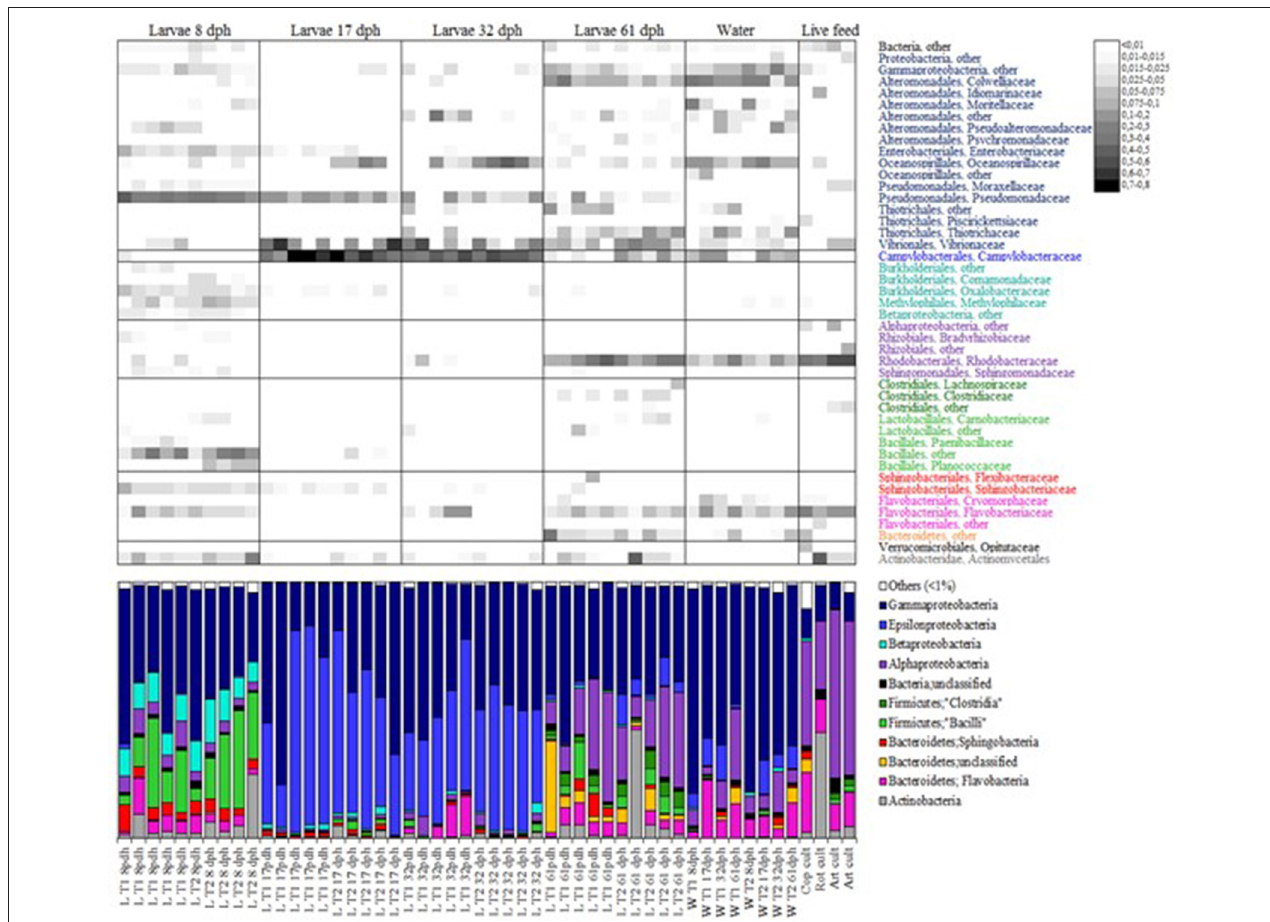
FIGURE 5 | Relative abundance of bacterial phyla and families in individual cod larvae, water and live food samples determined by 16S rDNA amplicon sequencing. At the phylum level, the microbiota is presented as percent bar graphs (bottom), and at the family level as a heat map (top, scale upper right) with the abundance of each family represented by a colored block as specified in the figure. Bars labeled D8, D17, D32, and D61 represent cod larva individuals at the ages of 8, 17, 32, and 61 dph, respectively. Bars labeled W and F represent water and live food samples, and the time of sampling is indicated in the label. Only taxa represented by a proportion of ≥ 1% in at least one of the samples are shown (from Bakke et al., 2015). Reproduced with permission from John Wiley and